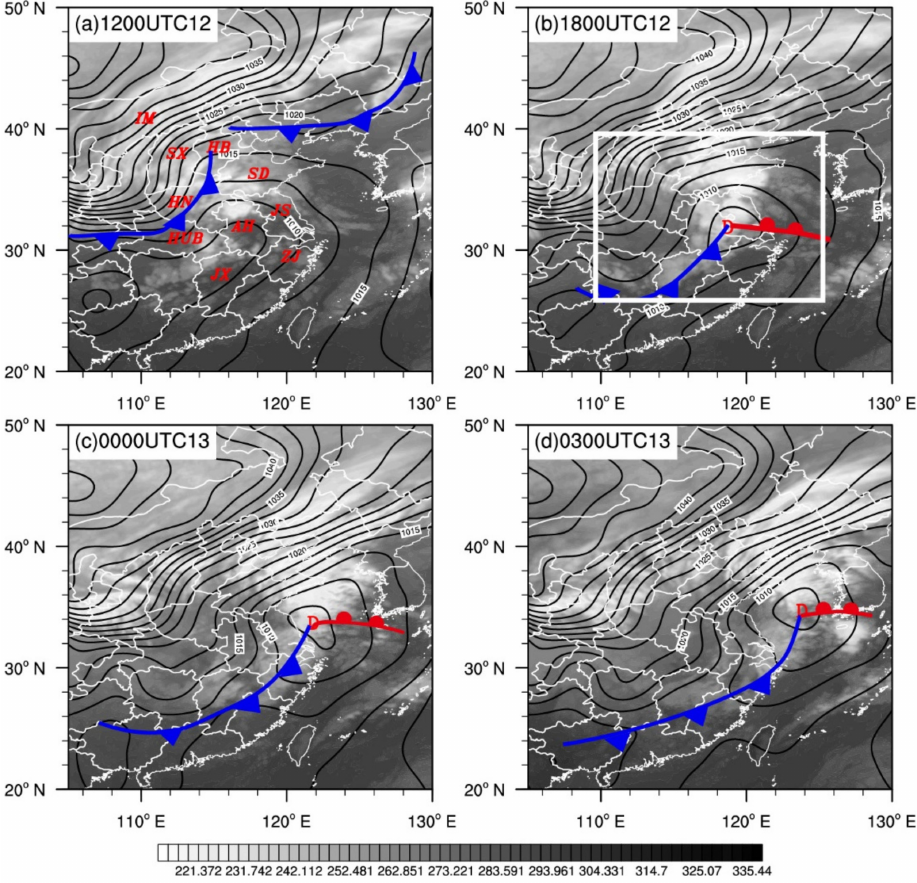
Figure 1. Infrared satellite images from FY-2G at ( a ) 1200 UTC 12 February, ( b ) 1800 UTC 12 February, ( c ) 0000 UTC 13 February, and ( d ) 0300 UTC 13 February 2016. Overlaid on the images are the surface low-pressure center (D), cold front (blue line with triangles), warm front (red line with semicircles) as well as the sea level pressure field (black lines; unit: hPa). The locations of Shandong (SD), Anhui (AH), Jiangsu (JS), Hebei (HB), Henan (HN), Shanxi (SX), Zhejiang (ZJ), Jiangxi (JX), and Hubei (HUB) Provinces are labeled in ( a